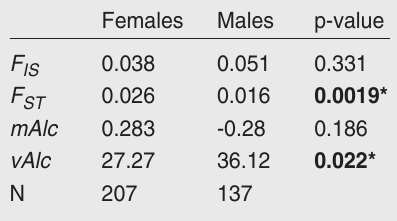
Table 5. Results of tests of sex-biased dispersal (mAlc = mean assignment index, vAlc = variance of the mean assignment index). BOLD : significant at the 5% level.